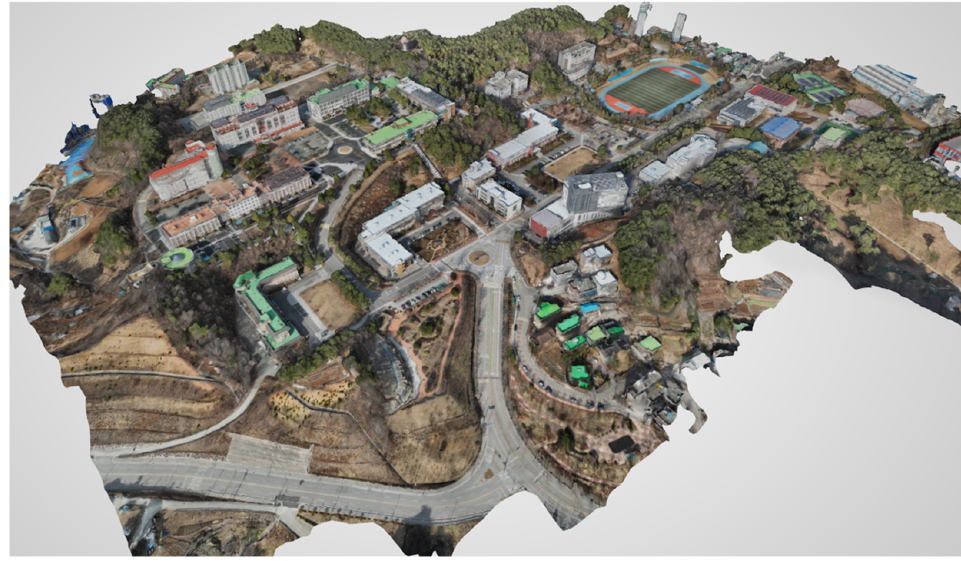
Figure 2. 3D model of Kangwon National University Samcheok Campus made by drone images.